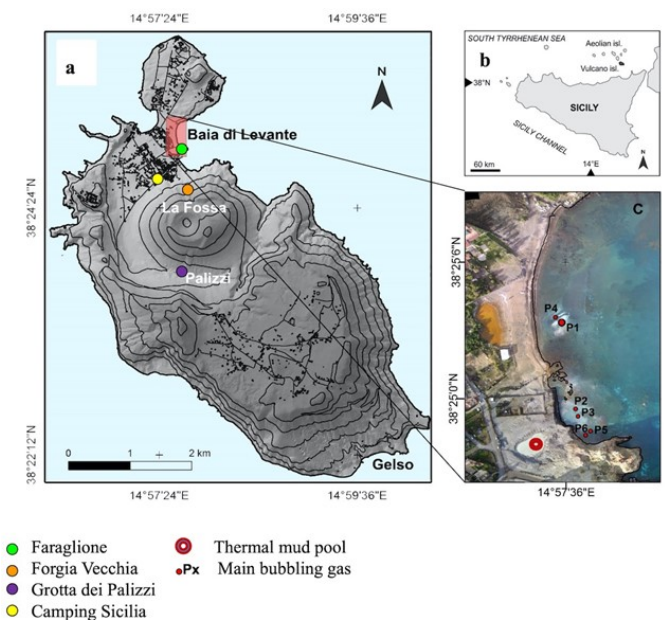
Figure 1. ( a ) Map of Vulcano Island (elevation contour interval 100 m) with location of the Baia di Levante area and of the main anomalous soil degassing points. ( b ) Location of Vulcano Island. ( c ) Detail of the Baia di Levante area with location of the main undersea hydrothermal vents from P1 to P6.